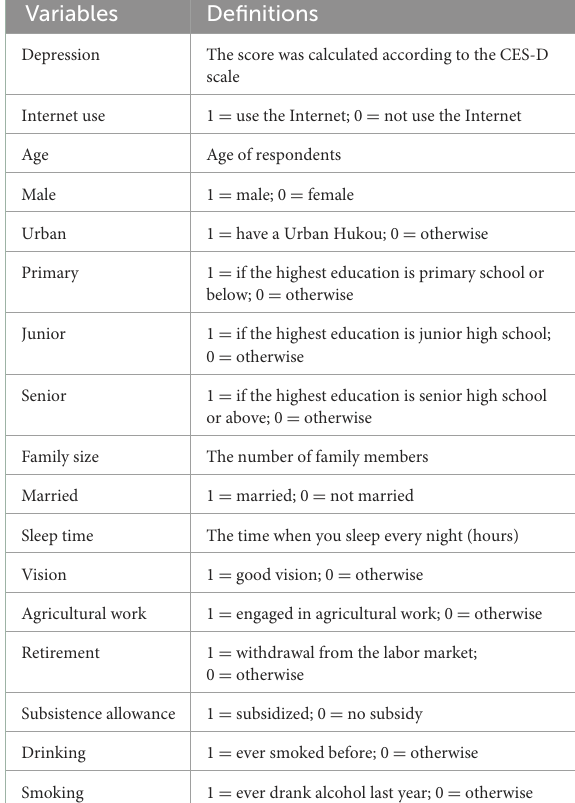
TABLE 1 Variable